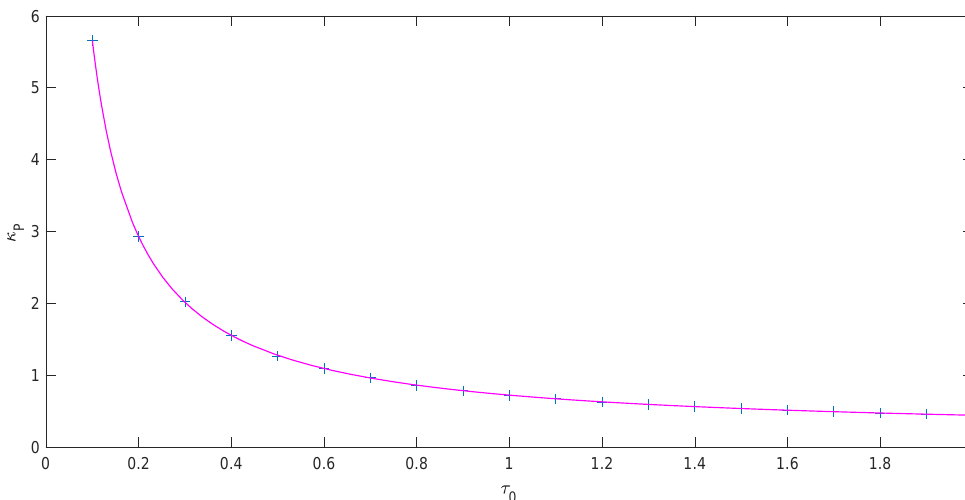
= 1.4). + are the optimal values for κ p . S